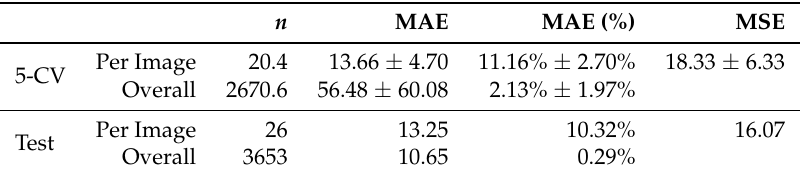
Table 4. Application of GBCNet on CR1 5-CV and test sets. The n column refers to the average number of images and berries per fold and in the test set.